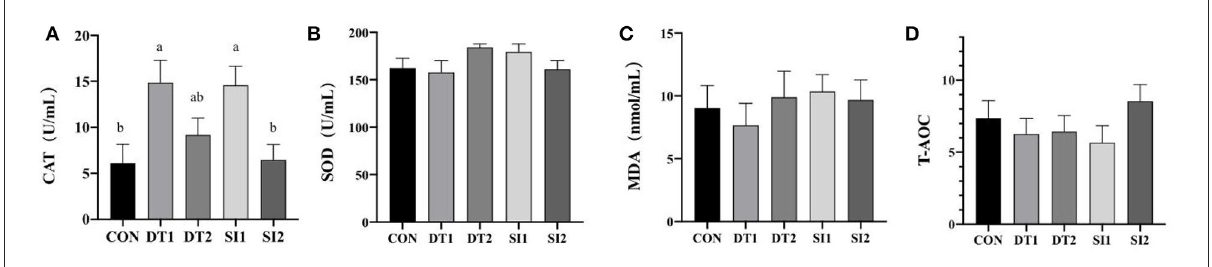
FIGURE1 (A–D) Effects of dietary dandelion tannins or soybean isoflavones on serum antioxidant indexes. a , b , c Marks indicate statistically significant differences ( P <